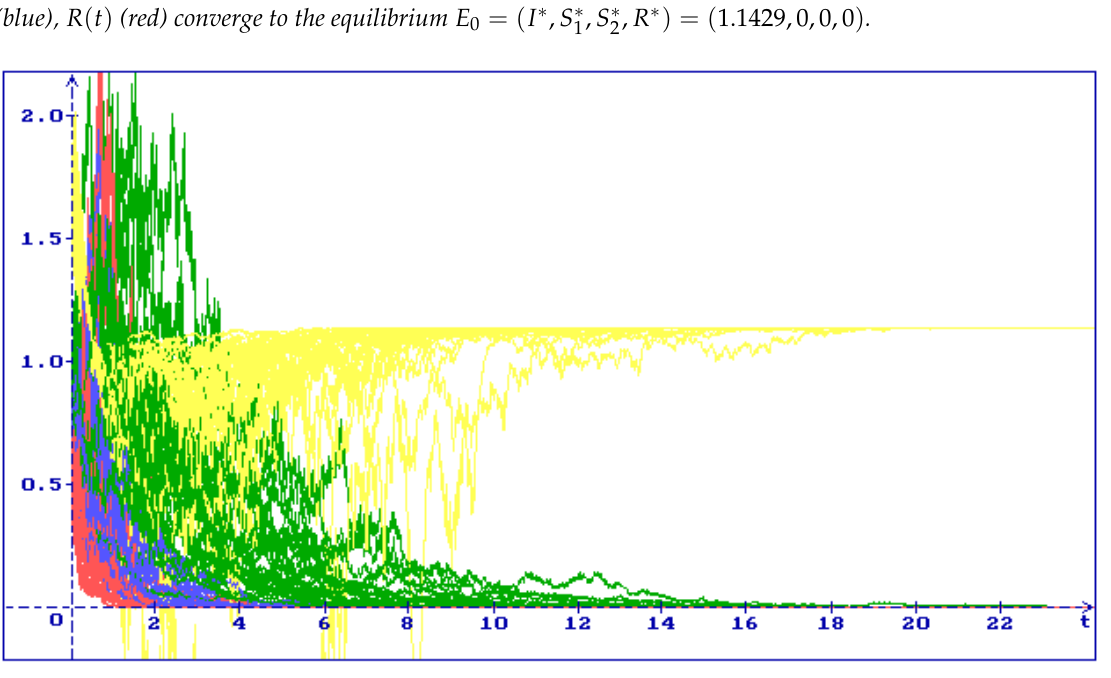
Figure 1. 30 trajectories of the system (6) solution with the initial condition I ( 0 ) = 1.7, S 1 ( 0 ) = 0.9, S 2 ( 0 ) = 0.7, R ( 0 ) = 0.5: all trajectories I ( t ) (yellow), S 1 ( t ) (green), S 2 ( t ) (blue), R ( t ) (red) converge to the equilibrium E 0 = ( I ∗ , S ∗ 4.2. Stability of the Equilibrium E 1 =